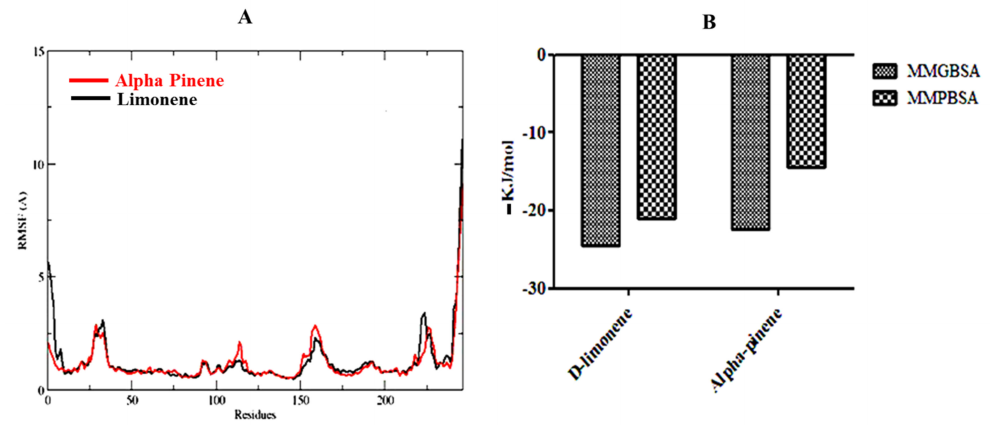
Figure 5. ( A ) RMSF plots of D-limonene and alpha-pinene complexes with 6CHZ (red is indicating D-limonene and black is indicating alpha pinene) and ( B ) MMGBSA and MMPBSA plots of D- limonene and alpha-pinene complexes with 6CHZ.